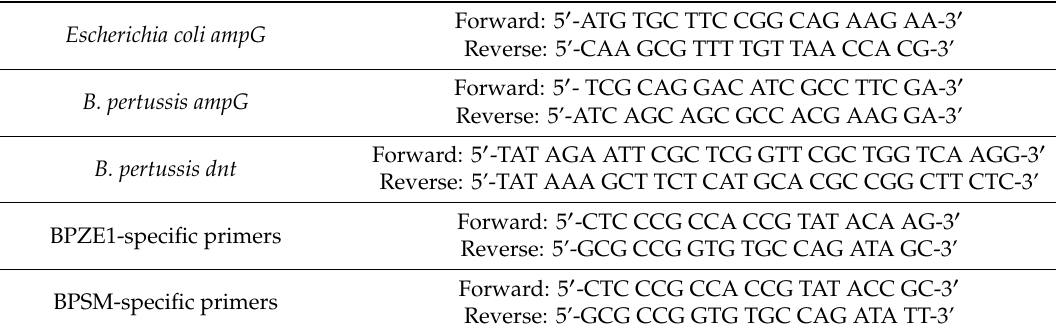
Table 1. Sequences of primers used for